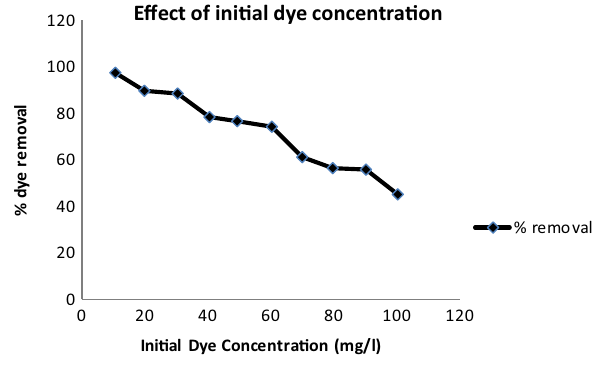
Fig. 11 Effect of initial dye concentration. *Adsorbent dose— 150 mg, agitation time—150 min, pH—6, temperature—30 °C, vol- ume—100 ml